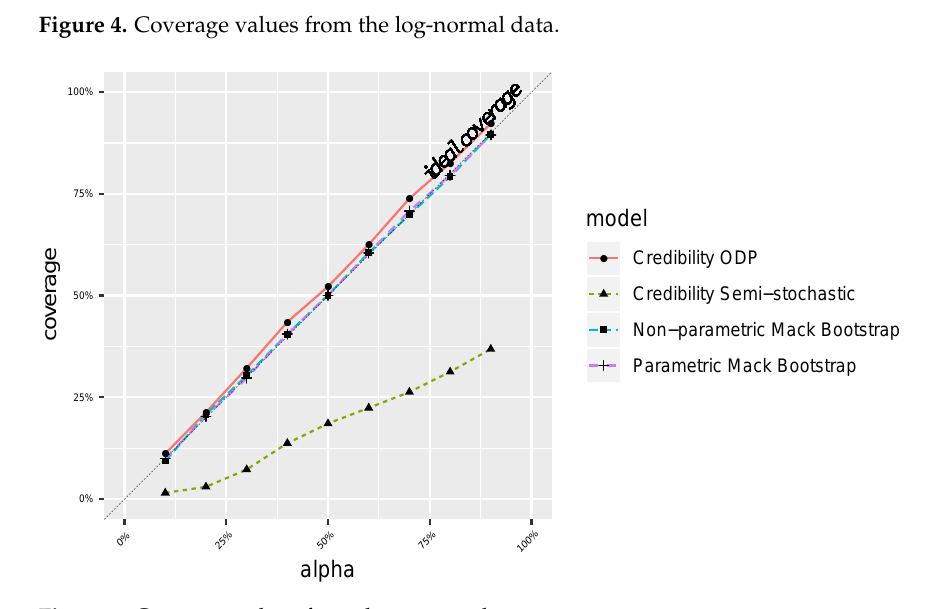
Figure 5. Coverage values from the gamma